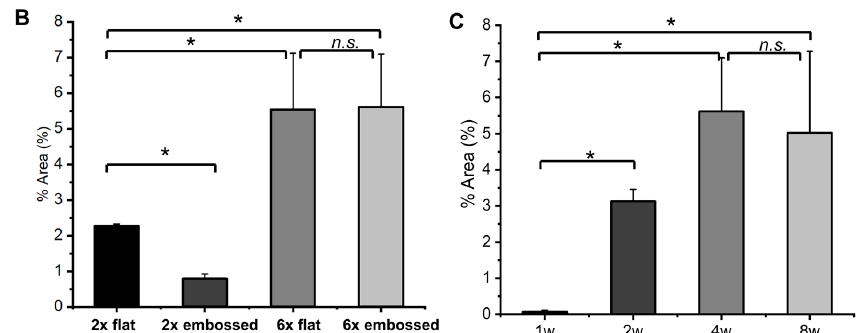
Figure 7. ( A ) Immunofluorescence images showing differences in Ang-1 expression in cross-sections of experimental groups at one, two, four, and eight weeks. Dashed lines indicate edge of transplanted embossed sheets. Arrowheads indicate Ang-1 expression in images after staining. Green: Ang-1, red: HUVEC, blue: DAPI. Scale bars are 200 µm. ( B ) Mean percent area of Ang-1 at four weeks within implanted layered sheet regions of interests (ROIs) in each experimental group. ( C ) Mean percent area of Ang-1 expression of group 6x embossed at one, two, four, and eight weeks. ( n = 4; data represent average ± SD, * P < 0.05).